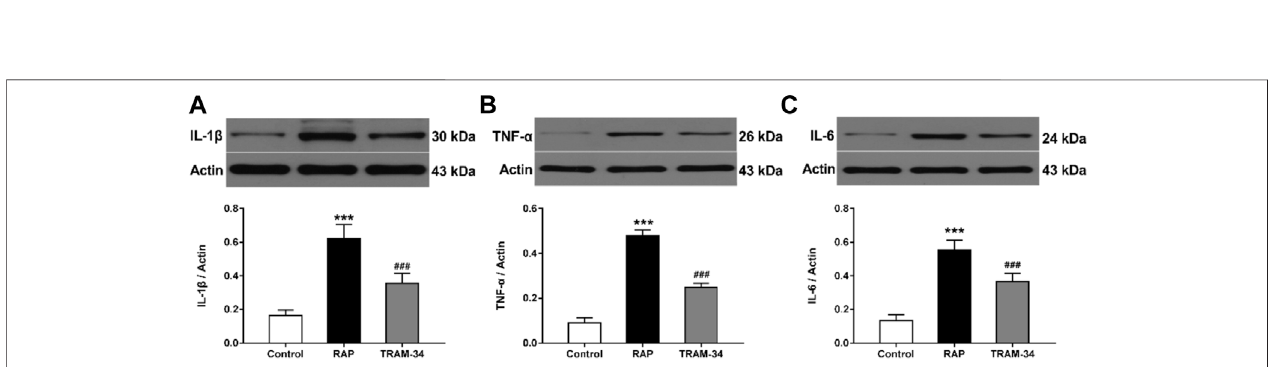
FIGURE6| Levelsofin fl ammatorycytokinesinthethreegroups.WesternblottingandquantitativeanalysisofIL-1 β ,TNF- α ,andIL-6inARGP (A – C) .*** p < 0.01vs the control group and TRAM-34 group; ### p < 0.01vs the control group.